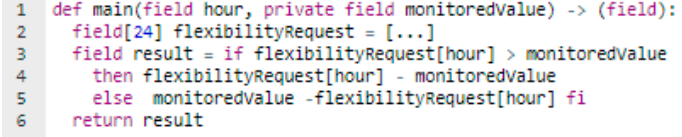
Figure 3. Function used by the aggregator for validating the prosumer response against the requested flexibility.